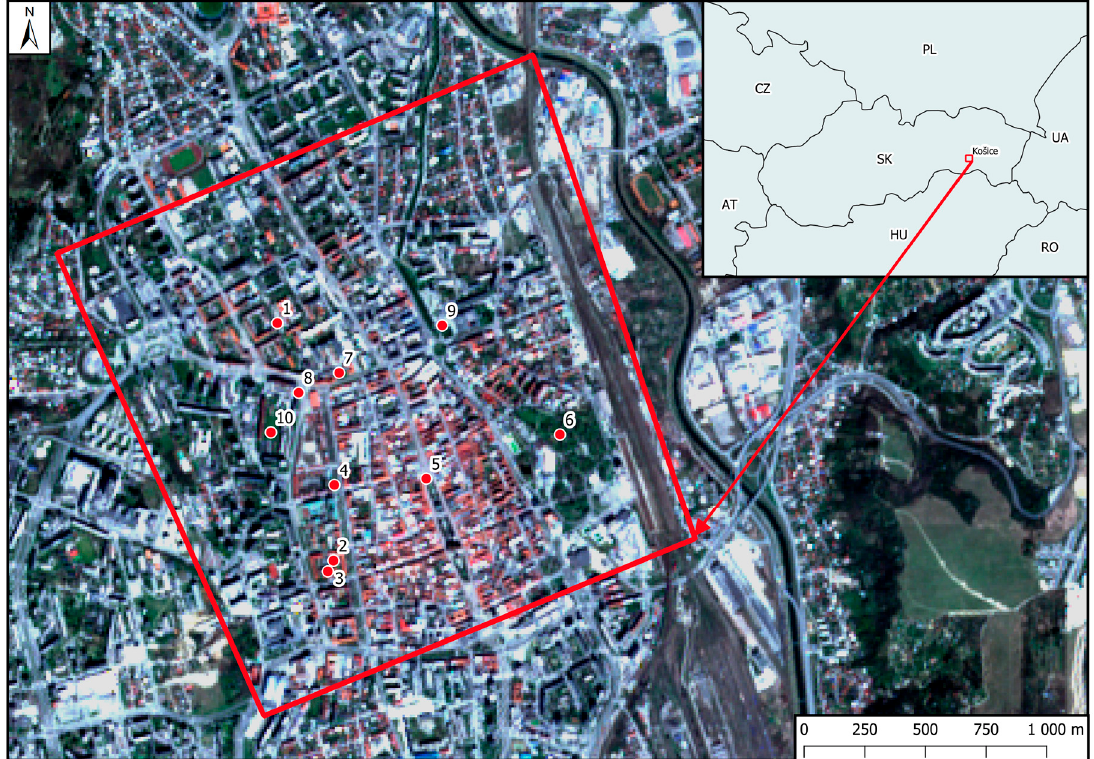
Figure 1. Location of the study area in the Košice City, Slovakia. The red line outlines the study area and red dots with numbers indicate locations subject to field measurements. The background map is © Copernicus, Sentinel 2A image acquired on 9 April 2020.